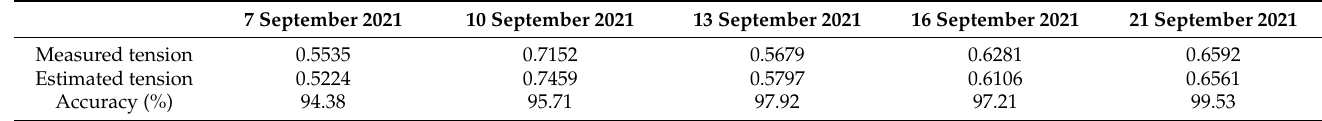
Table 3. Accuracy of the average correlation coefficient (measured tension vs. estimated